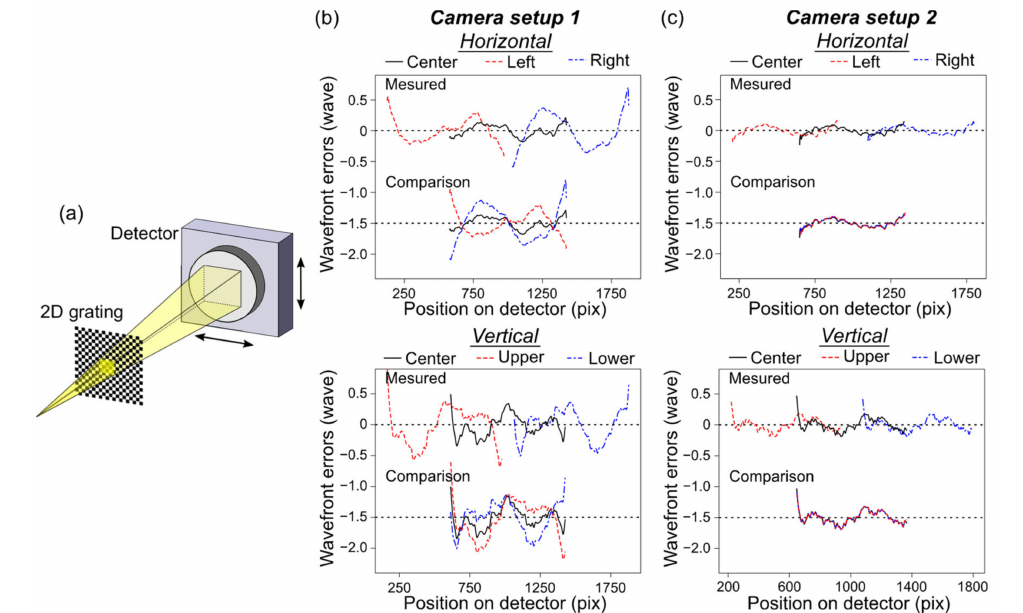
Figure 4. Dependences of the detector position. ( a ) Schematic drawing of the measurement setup. The detectors were laterally shifted in the horizontal and vertical directions. Two camera setups described in the main text were utilized. ( b , c ) Averaged wavefront error profiles along the horizontal (top) and vertical (bottom) directions, which were obtained using camera setup 1 ( b ) and 2 ( c ). For clarity, comparison profiles are shifted by − 1.5 waves in ( b ) and ( c